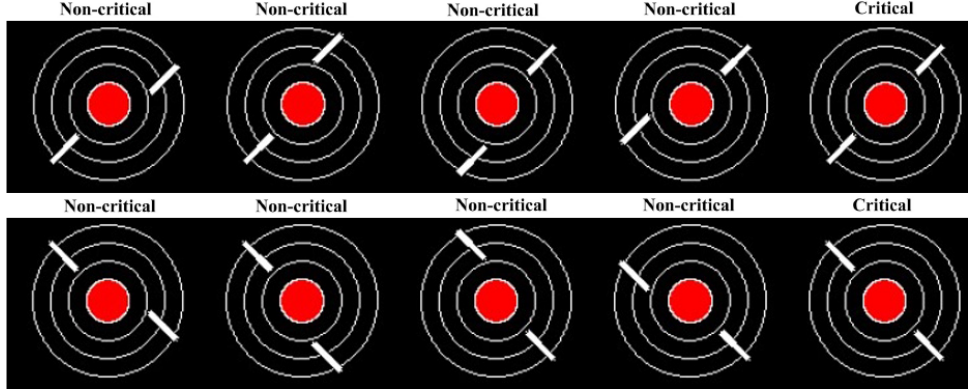
Figure 1. Examples of the different Air Traffic Controller Task stimuli